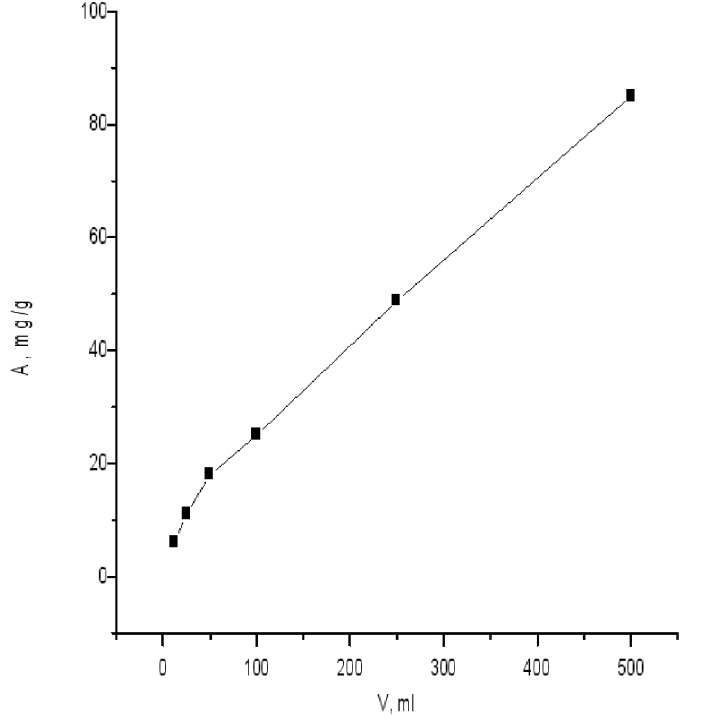
Fig. 1 Adsorption isotherm of trypsin by carbon fabric (1